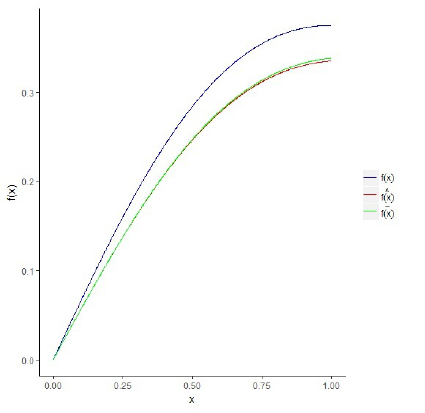
Figure 3 – MLE and UMVUE of sampled